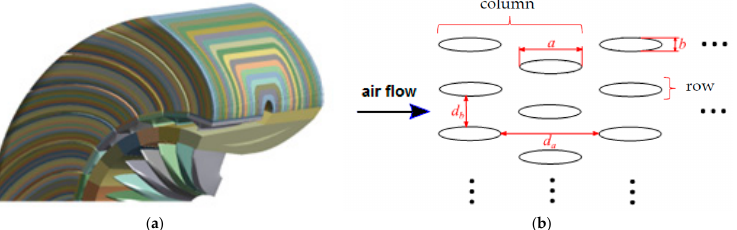
Figure 4. Illustrations of the involute spiral two-pass cross flow intercooler concept in 3D, reproduced with permission from [32], T. Grönstedt, 2017 ( a ); and the arrangement of the elliptical tubes in ( b ). All correlations contained in [29,30] were originally derived from CFD experiments featuring air as the medium on both sides. This makes them non-ideal for application to S-CO 2 . However,